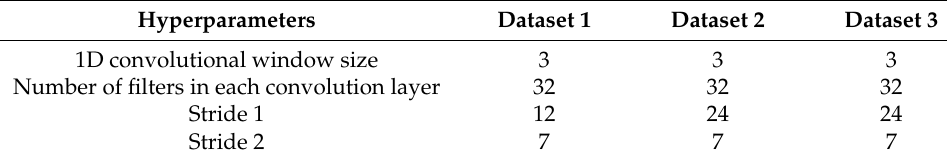
Table 4. Configuration for the heuristic-stride-TCN for three datasets. Hyperparameters Dataset 1 Dataset 2 Dataset 3 1D convolutional window size 3 3 3 Number of filters in each convolution layer 32 32 Stride